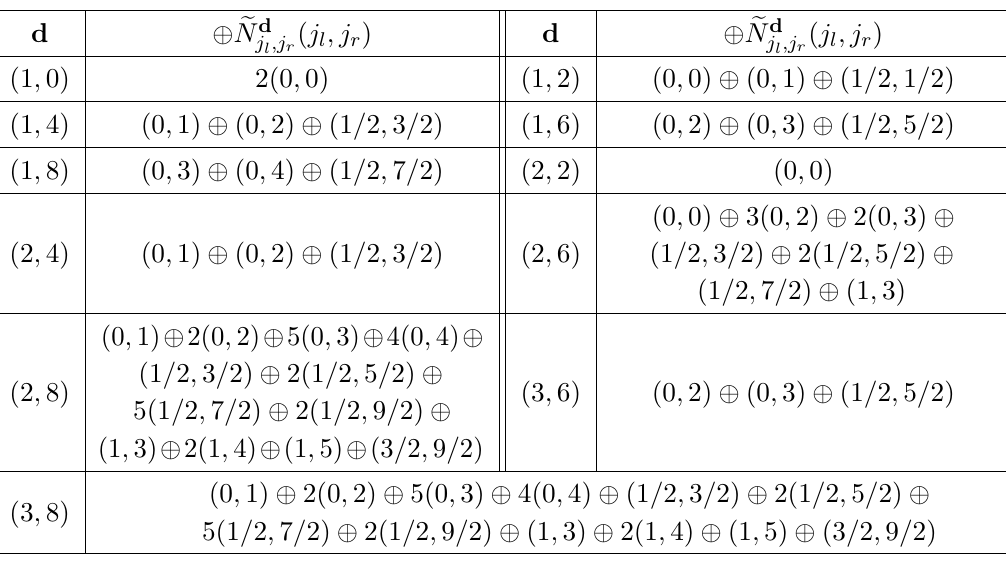
Table 2 . Pseudo-BPS Spectrum of SU(2) Wilson loop expectation value in the representation 2 ⊗ 2 for the curve class d 1 m 0 + d 2 φ with d 1 = 1 , 2 , 3 , and d 2 ≤ 8 . The d 1 = 0 part can be read from (3.47).